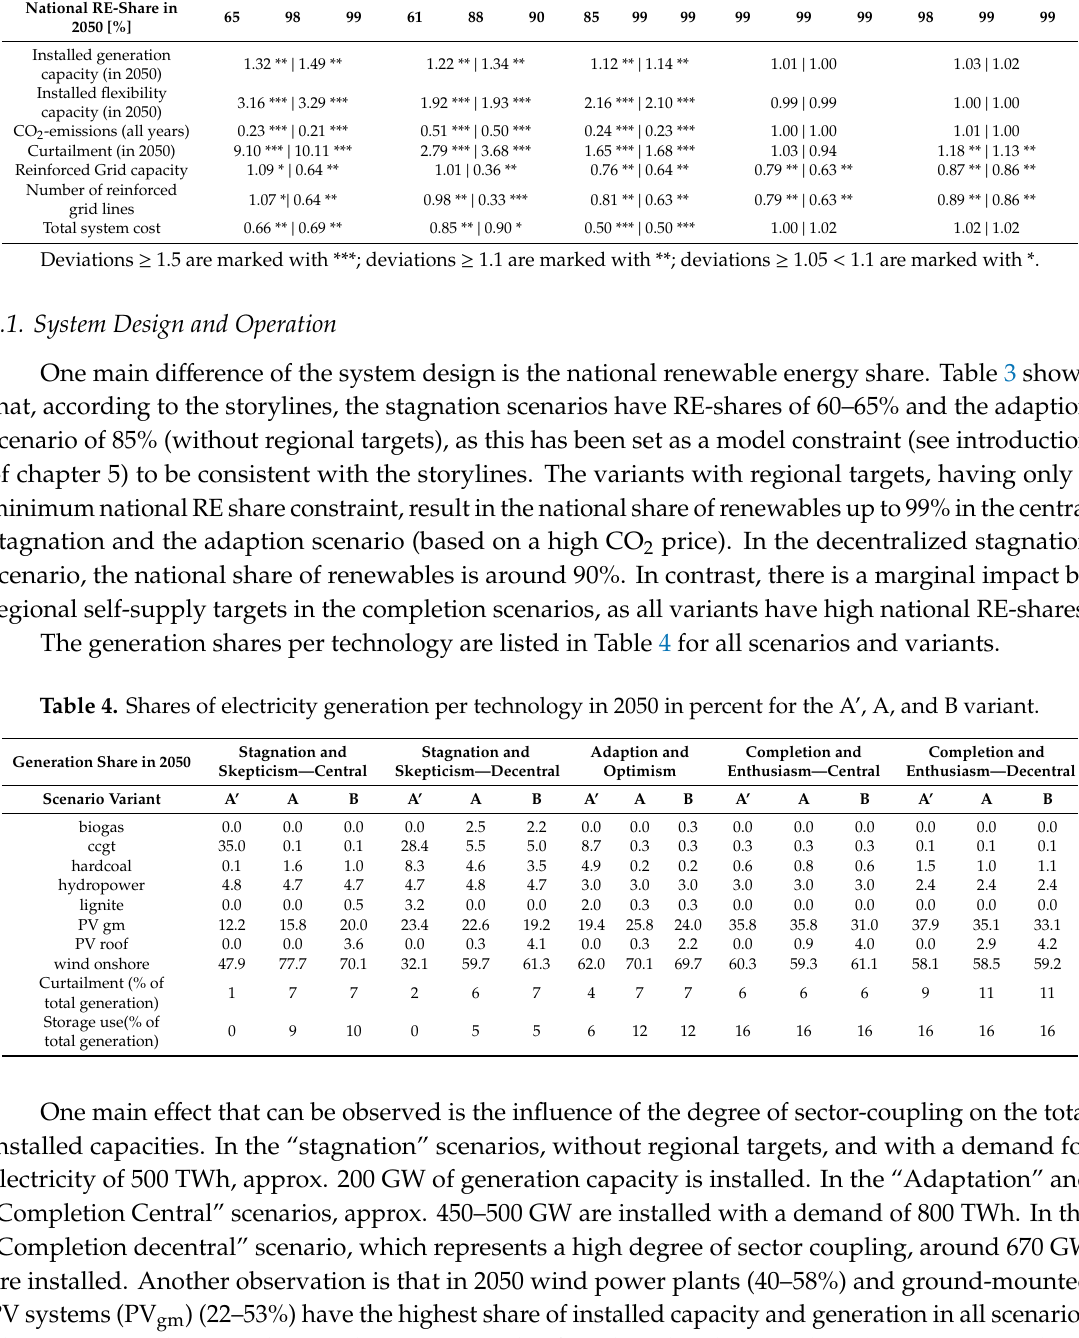
Table 3. Percentage deviation of the scenarios (A / A’ | B / A’) with and without self-supply targets for general energy system parameter. Percentage Deviation of Stagnation and Skepticism—Central Stagnation and Skepticism—Decentral Adaption and Optimism Completion and Enthusiasm—Central